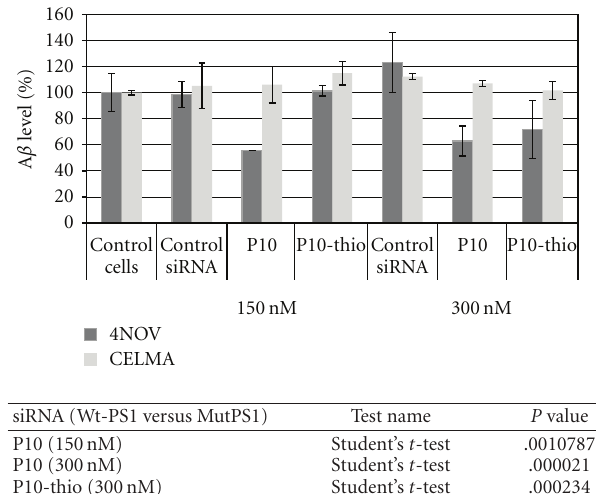
Figure 6: The normalized values of the extracellular A β 42 levels in medium of cells transfected with the siRNA duplexes. Human fibroblasts expressing endogenously the wild type PSEN1 gene (CELMA) and L392V mutant (NOV4) were cultured in the presence of P10, P10-thio, and control nonsilencing siRNA duplexes (150 and 300 nM). After 48-hour incubation, the culturing medium was collected with 1mM AEBSF, and the level of A β 42 was measured by sandwich ELISA test. Data are presented as percentage values to control cells treated with lipofectamine only. The results are mean values from two independent experiments. Statistical analysis of di ff erences between two groups of data (Wt-PSEN1 versus Mut-PSEN1) were calculated by the use of Student’s t -test (data with normal distribution). All di ff erences were considered as statistically significant.